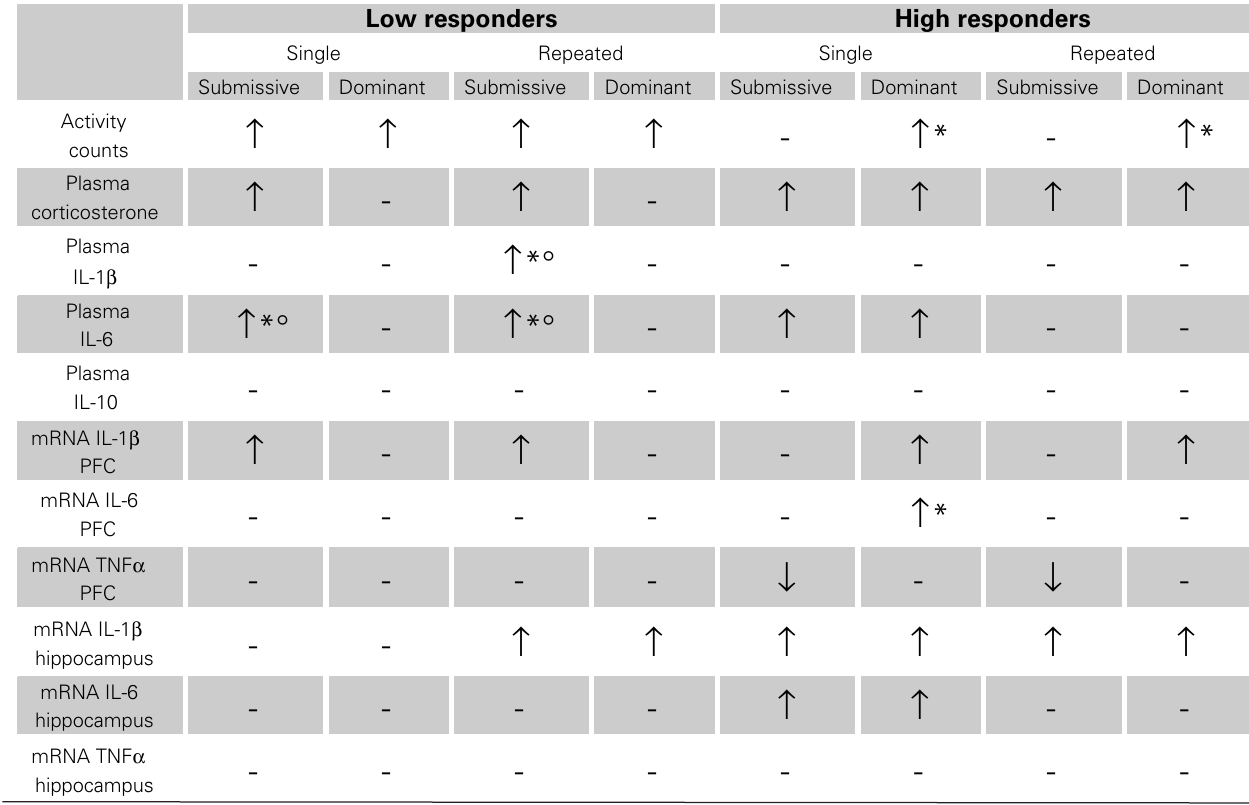
Table 1 | Variations of home-cage activity, plasma corticosterone and cytokines levels, as well as brain mrNA expression of pro-inflammatory cytokines after single or repeated aggressive encounters among submissive and dominant mice that were low or high corticosterone